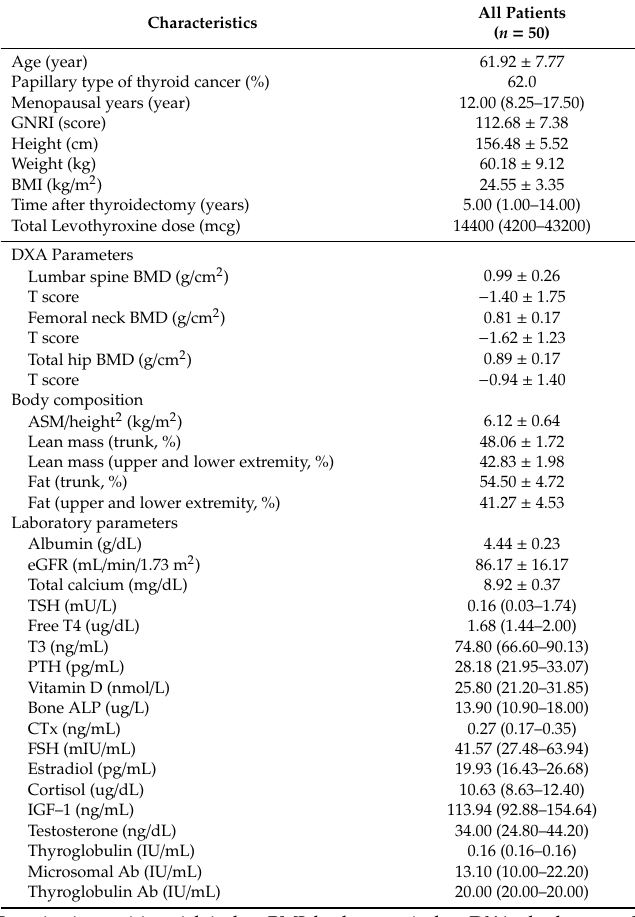
Table 1. Baseline and dual energy X-ray absorptiometry (DXA)